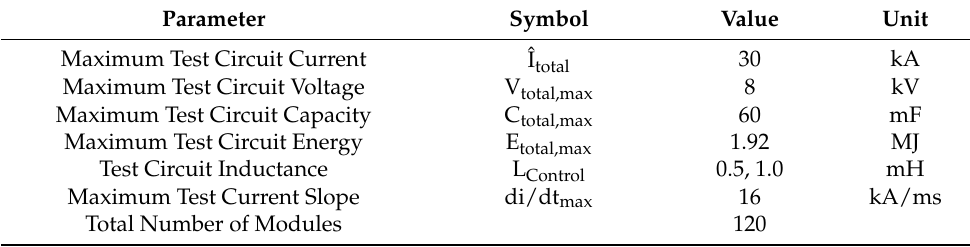
Table A2. Ratings of overall high-power test